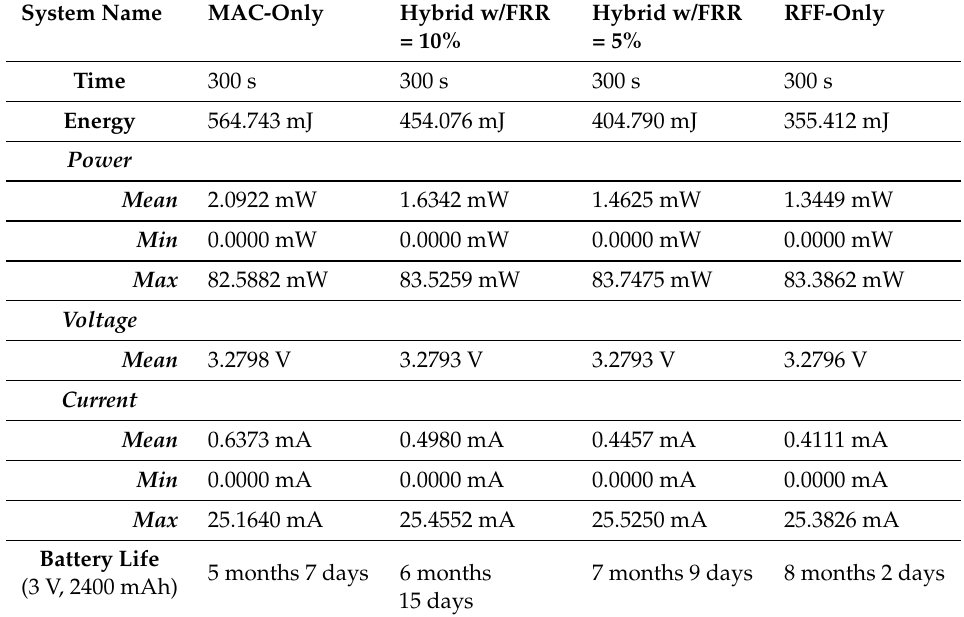
Table 1. Energy measurement comparison.